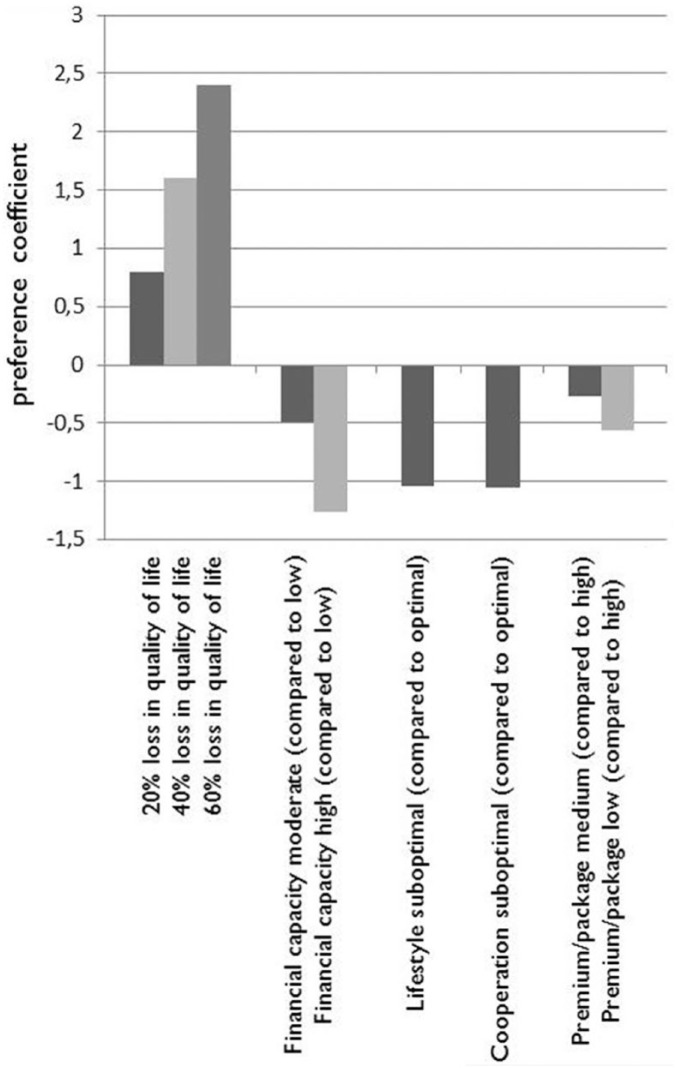
Visualized trade-offs of the health care deservingness criteria.